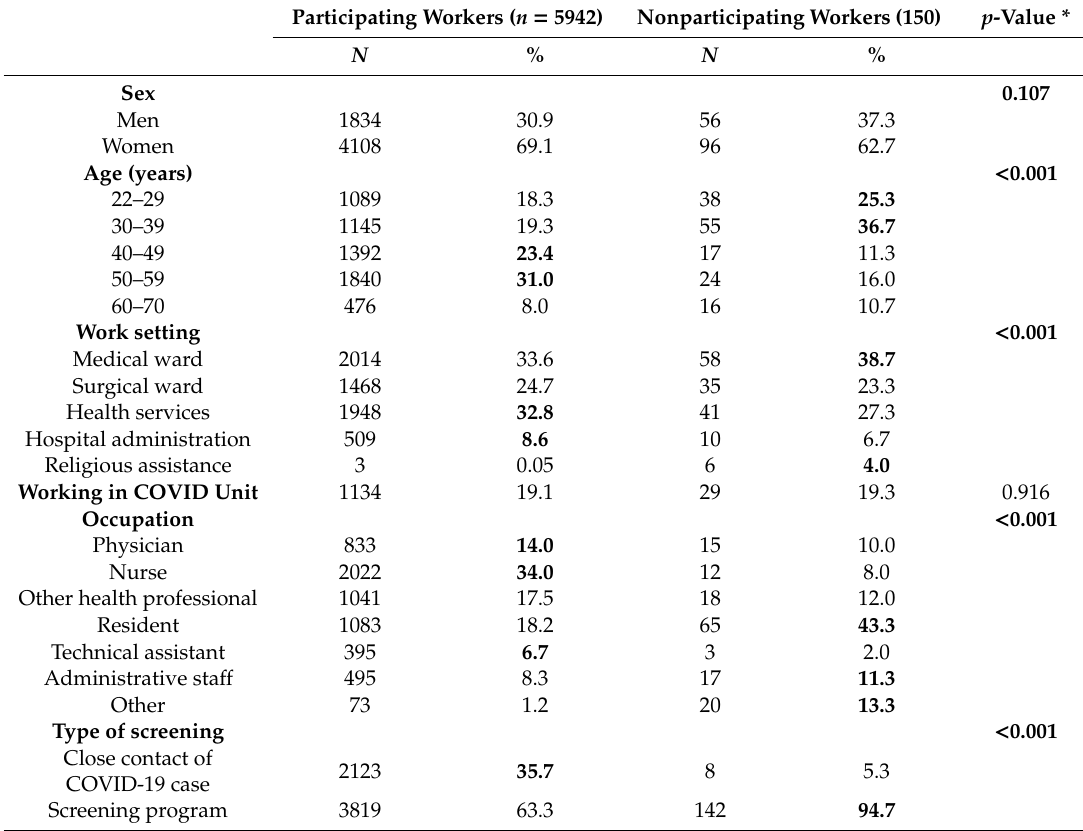
Table1. Maindemographicandoccupationalcharacteristicsofworkersparticipatingornotparticipating in the